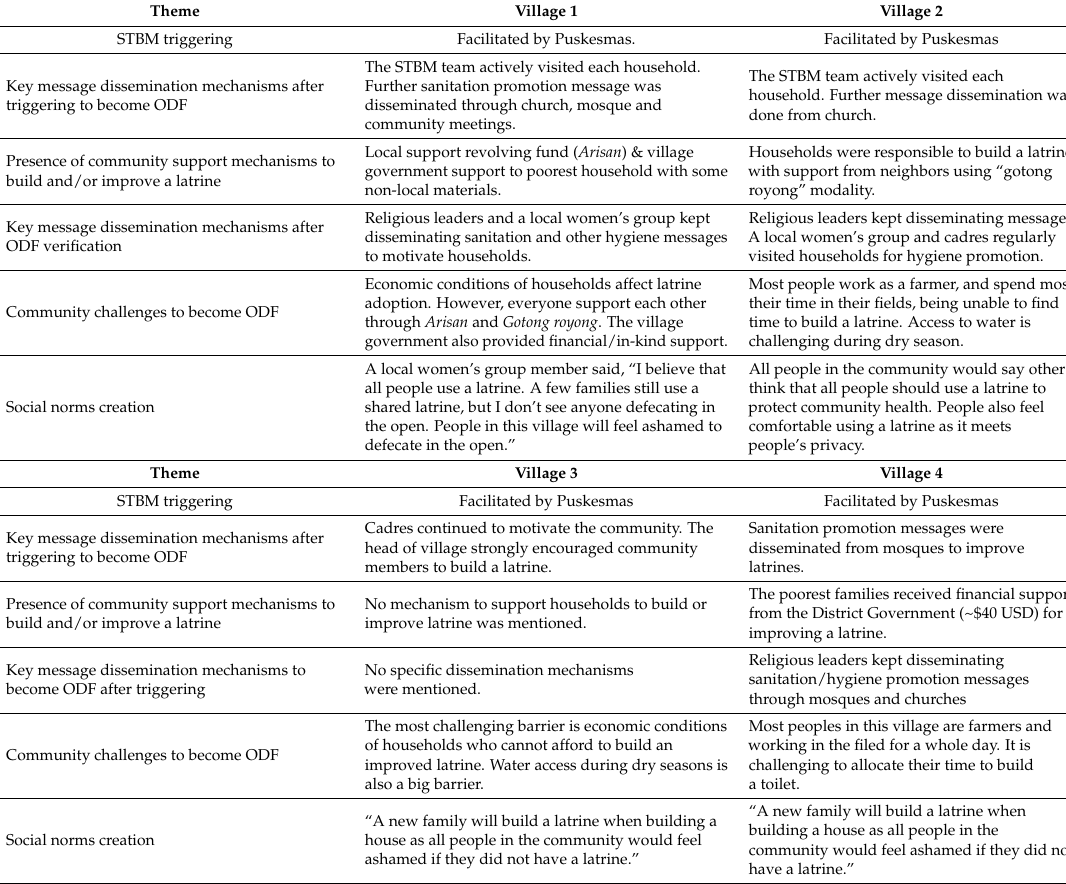
Table 5. A summary of Focus Group Discussions (FGDs) in six Open Defecation Free villages.